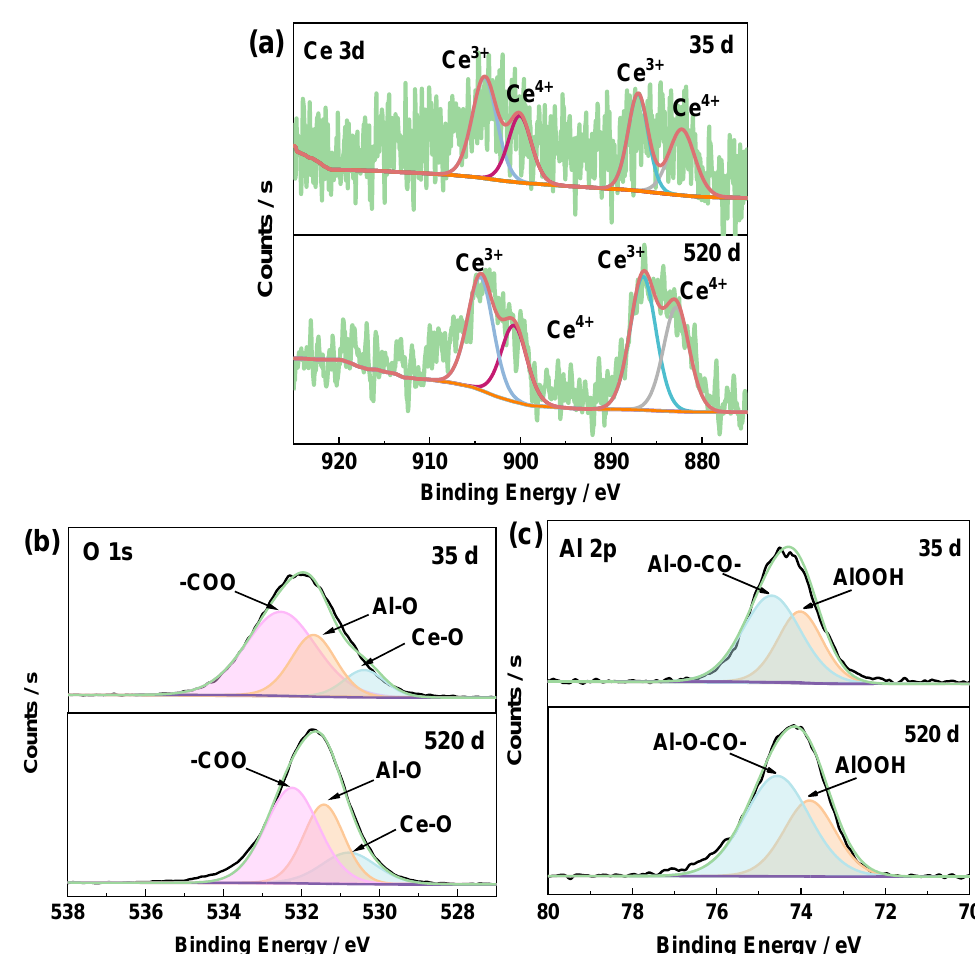
Figure 15. XPS spectra of the substrate surface under single-layer coating after immersion in 3.5% NaCl solution for 35 d and 520 d: ( a ) Ce 3d; ( b ) O 1s; ( c ) Al 2p.